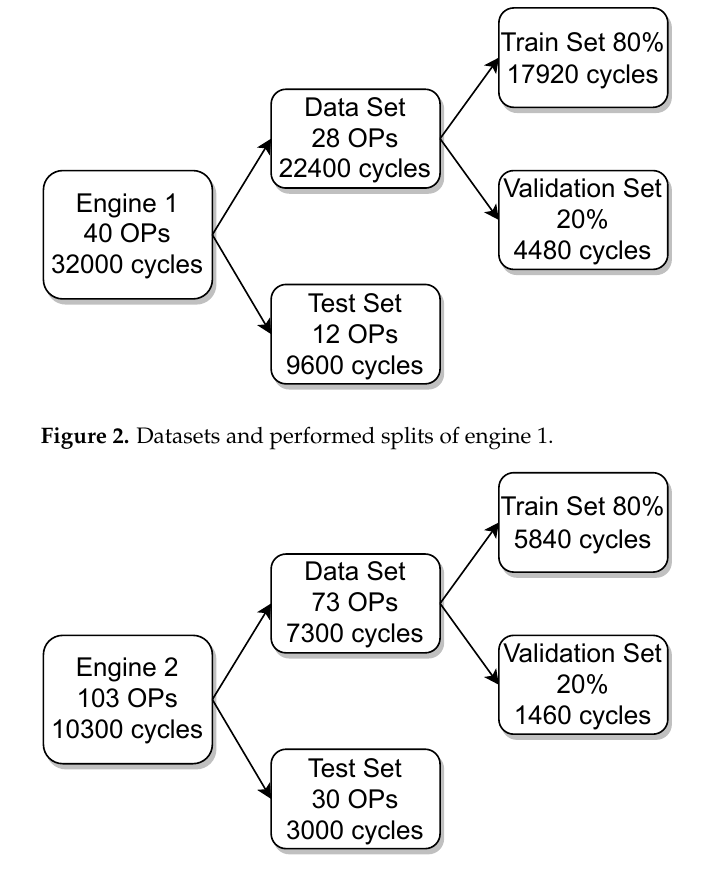
Figure 3. Datasets and performed splits of engine